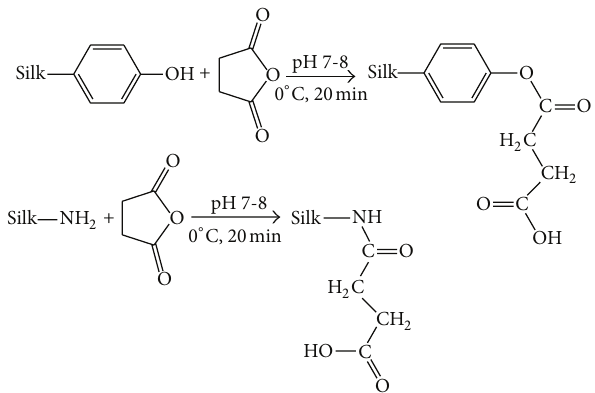
Figure 1: Some potential reactions between Ap -SF and succinic